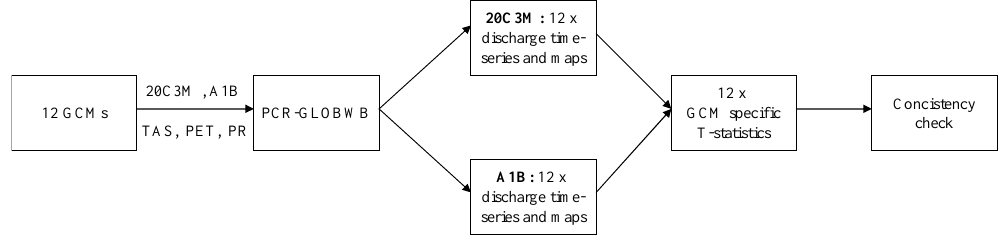
Fig. 2. Schematization of experimental